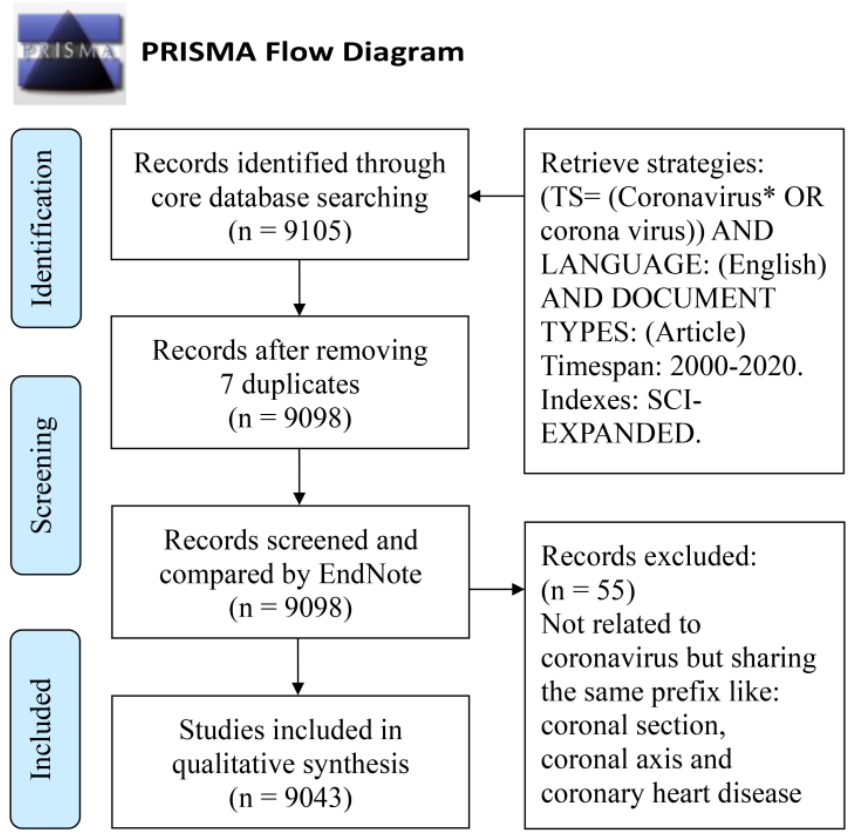
Figure 1. Flowchart of data screening and inclusion.